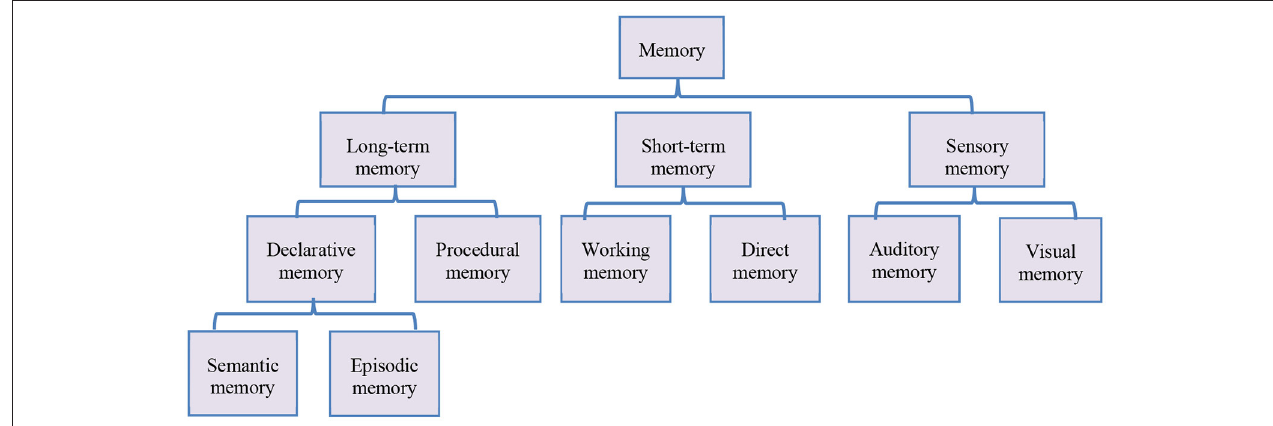
FIGURE 4 | Memory